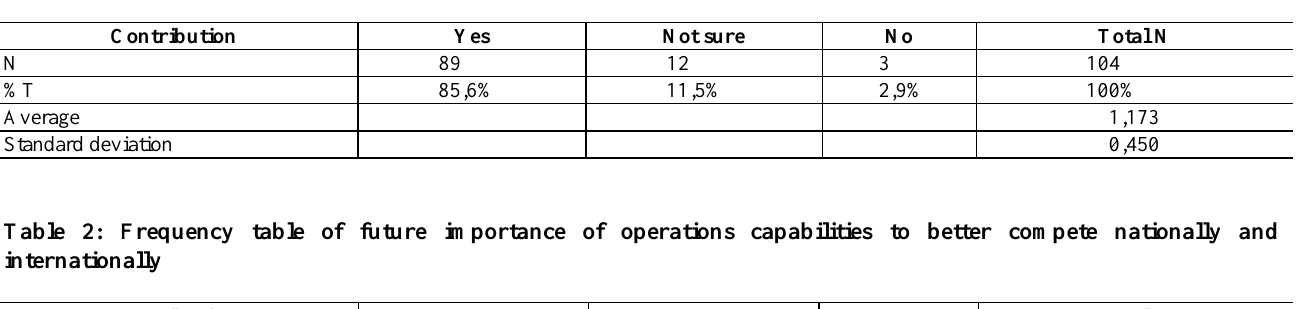
Table 1: Frequency table of contributions of operations strategy towards the company’s long-term, superior business performance and success